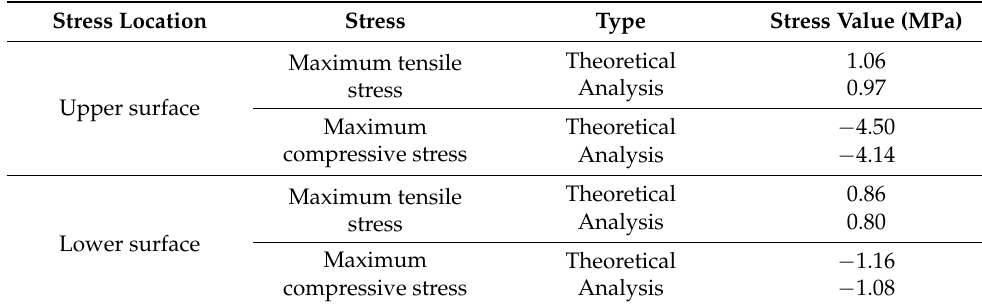
Table 7. Maximum stresses on the upper and lower surfaces of the CLS span. Stress